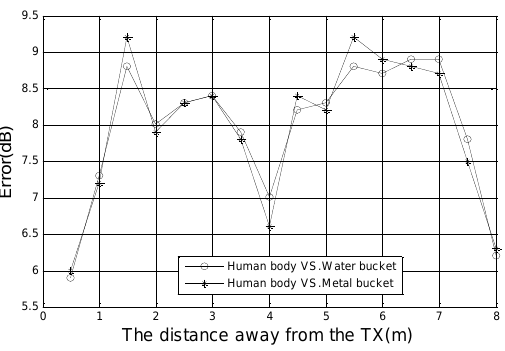
Figure 7. Comparing the measurement results between the human body and the cylinders.